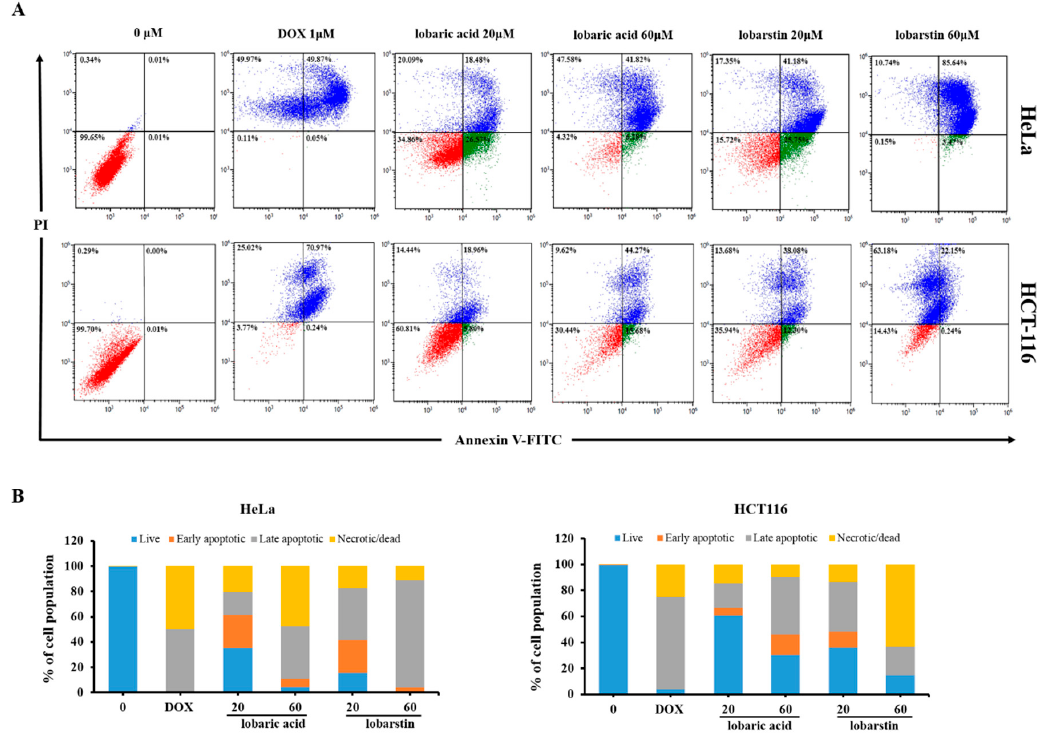
Figure 4. Effect of lobaric acid and lobarstin on the apoptosis of HeLa and HCT116 cells. The cells were stained with annexin V/propidium iodide (PI), and the apoptotic cell population was evaluated by flow cytometry ( A ). The graphical representation of the percentage of live, early apoptotic, late apoptotic, and necrotic/dead cells is shown ( B ).